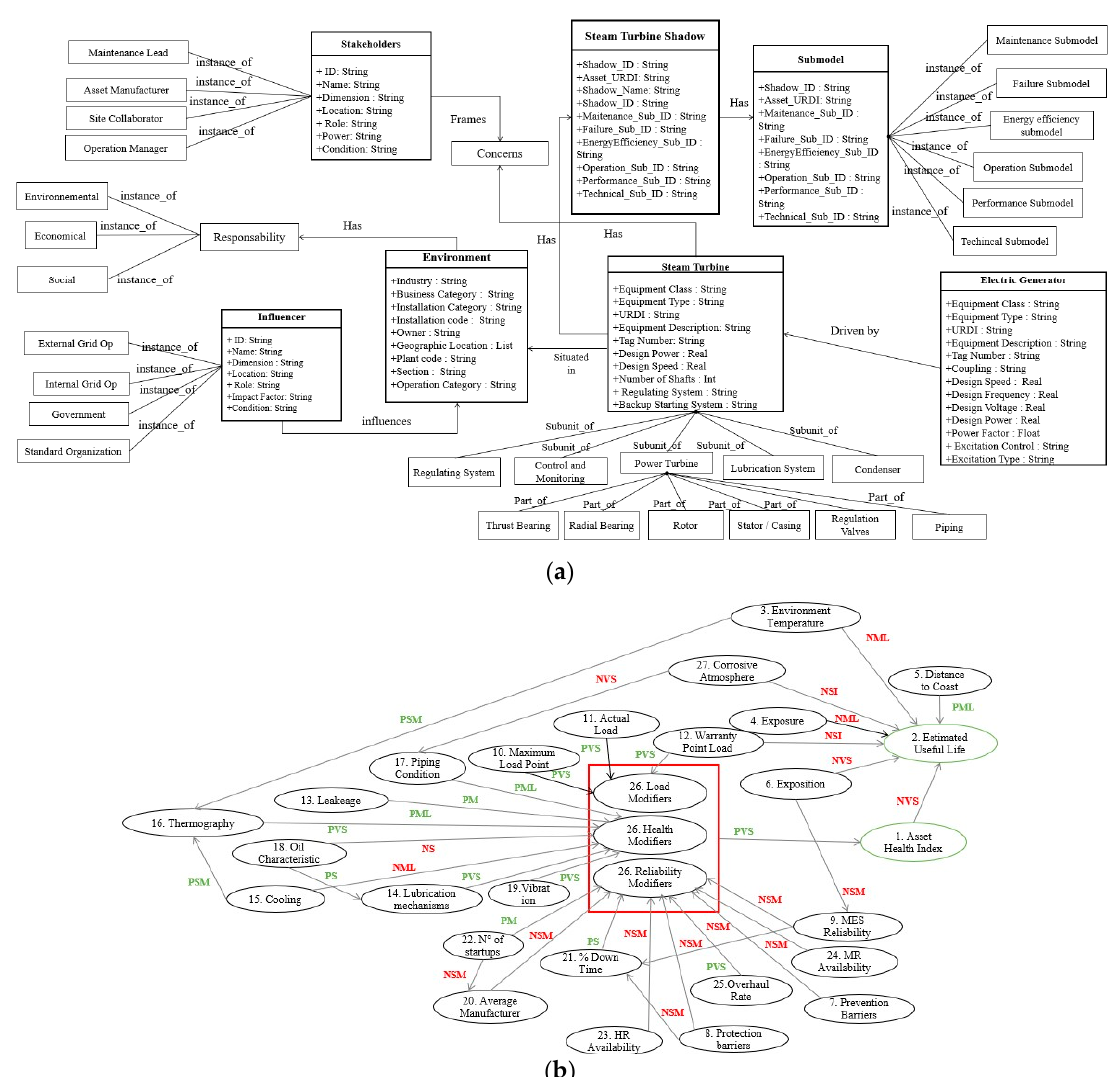
Figure 5. HT OMASE environment view for the use case—domain model for steam turbine according to modified system boundaries by ISO ( a ). Cognitive map for health index definition ( b ) .